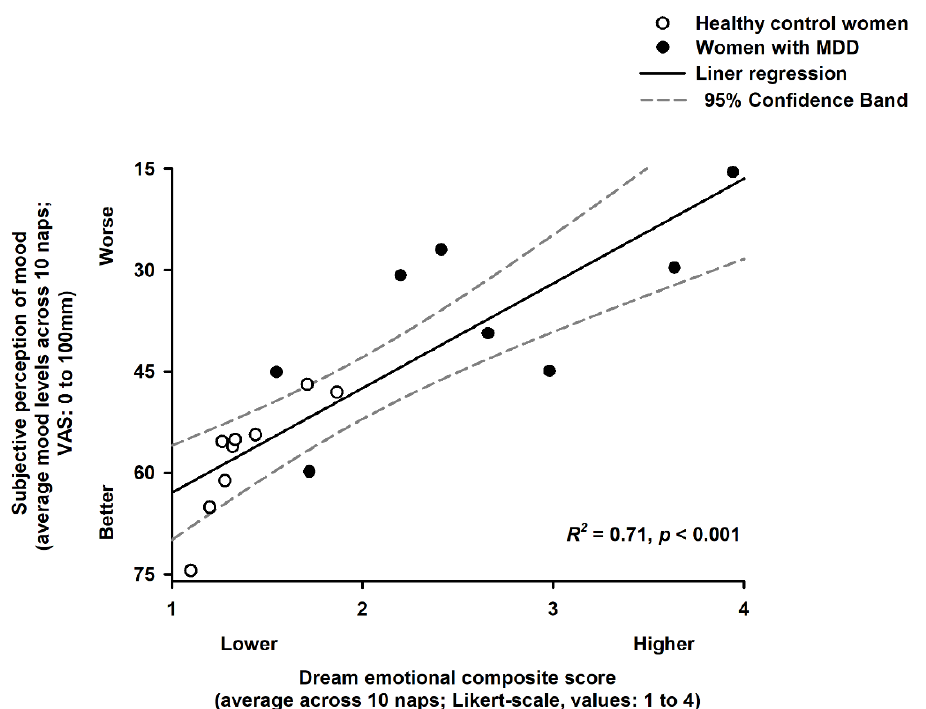
Figure 6. Association of dream emotional load and subjective perception of mood. The dream emotional composite score was significantly associated with the degree of changes in mood levels during the 40 h multiple nap protocol (R 2 = 0.71; p < 0.001). Data averaged across the 10 naps. Black and white circles are, respectively, the individual data for women with MDD and for the healthy control women. Solid and dashed lines correspond to, respectively, the linear regression model and the 95% confidence interval.